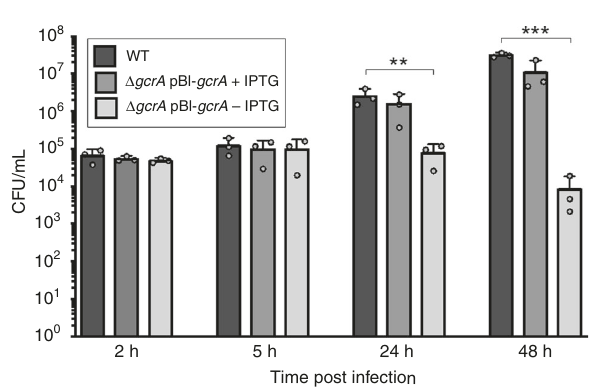
Fig. 7 Infection of RAW 264.7 macrophages with the GcrA depleted strain. Colony-forming units were counted after 2, 5, 24, and 48 h post infection for the WT and the GcrA depleted strains incubated with or without IPTG ( + IPTG or − IPTG, respectively). Error bars represent standard deviations ( n = 3). A Scheffe statistical analysis reveals that, in the absence of IPTG, the GcrA-depleted strain is attenuated at 24 ( p < 0.01, **) and 48 h ( p < 0. 001, ***) post infection in this cell type. Source data are provided as a Source Data fi